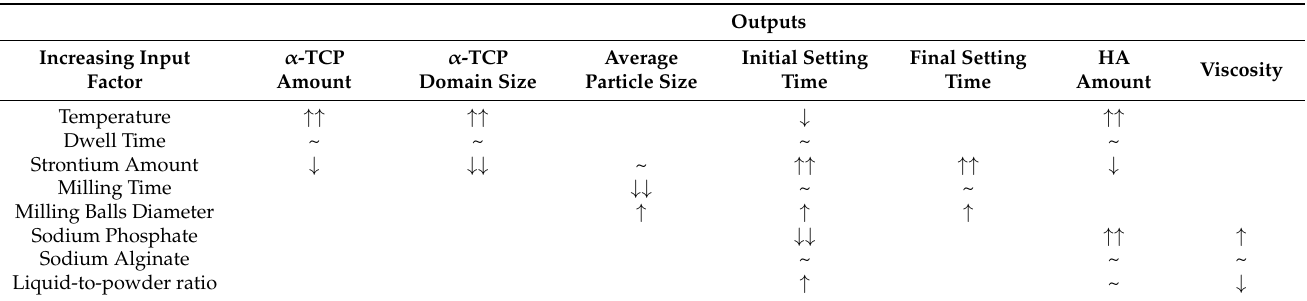
Table 2. The qualitative correlation of each increasing factor on the outputs is reported as positive (arrows up), negative (arrow down), statistical significance (double arrow), or negligible statistical significance ( ~ ). Outputs α -TCP α -TCP Increasing Input Average Initial Setting Final Setting HA Factor Amount Domain Size Particle Size Time Time Amount